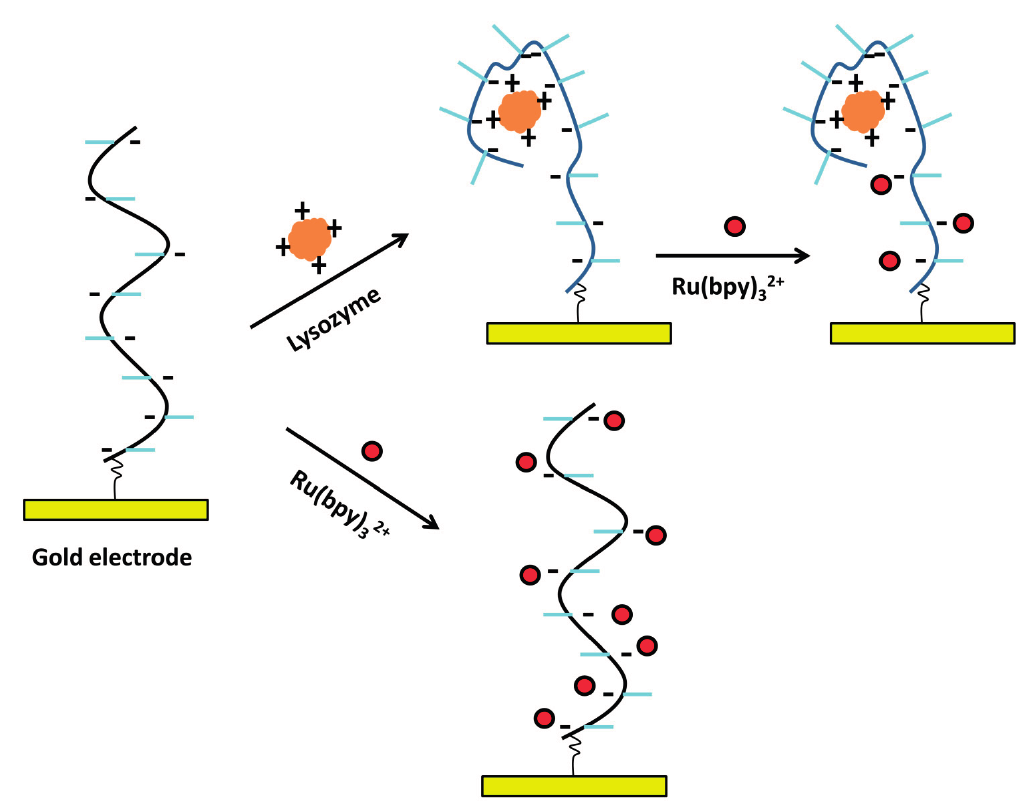
Figure 23. Label-free ECL sensing platforms for lysozyme determination using Ru(bpy) 32+ as luminophores. Reprinted with permission from ref. [223], copyright (2011)